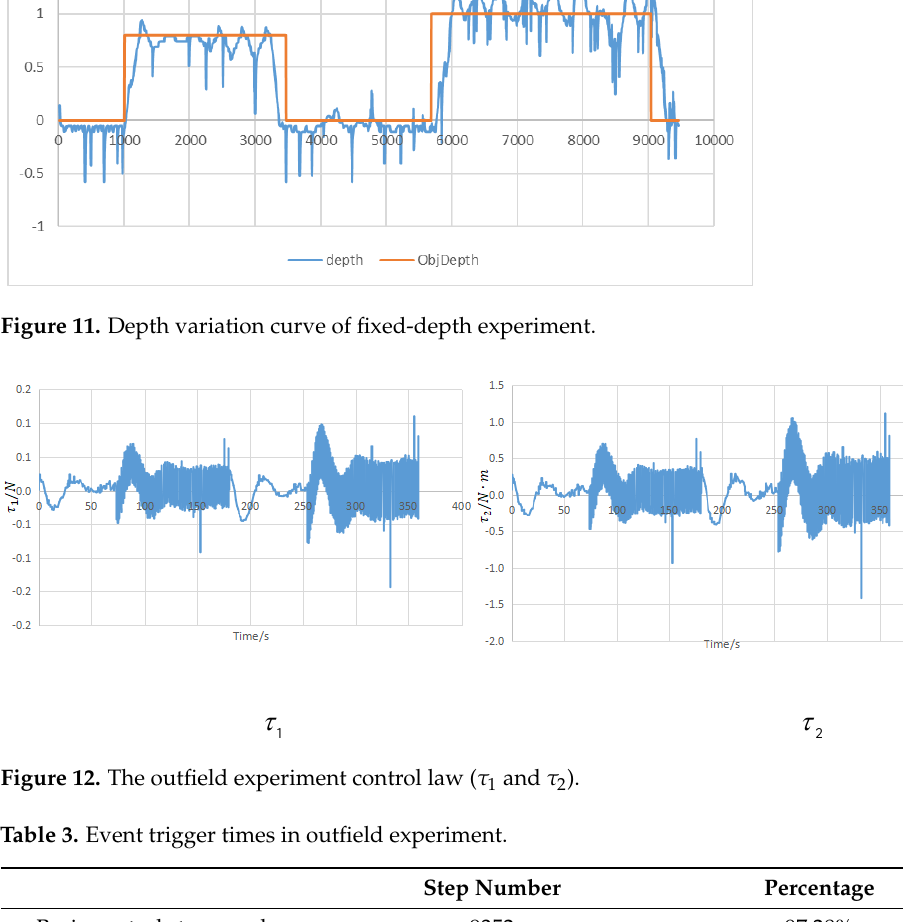
Figure 11. Depth variation curve of fixed-depth experiment.